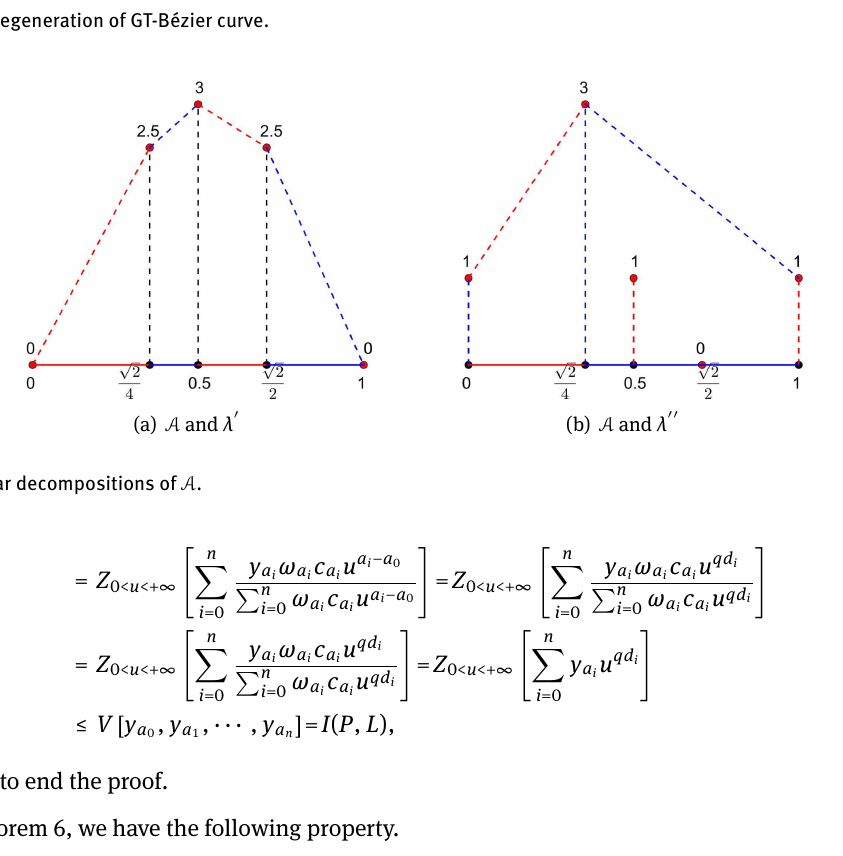
Figure 11: Toric degeneration of GT-Bézier curve.